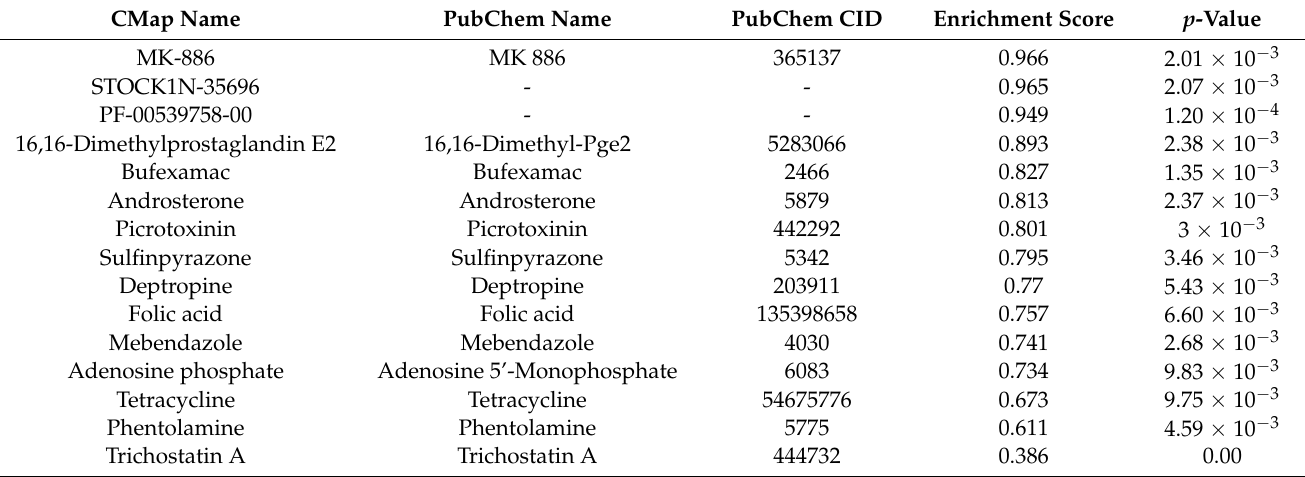
Table 4. Bioactive molecules discovered by CMap as potential drug candidates for ALS ( p <